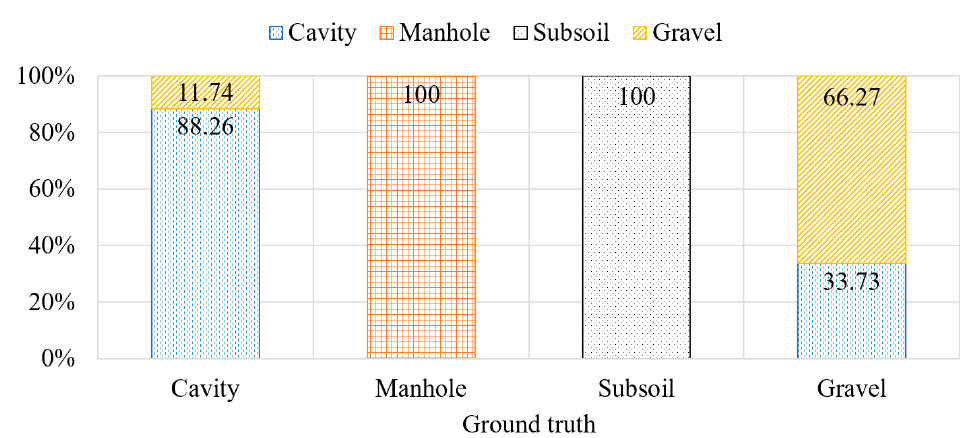
Figure 12. The results of conventional convolutional neural network (CNN)-based underground object classification.